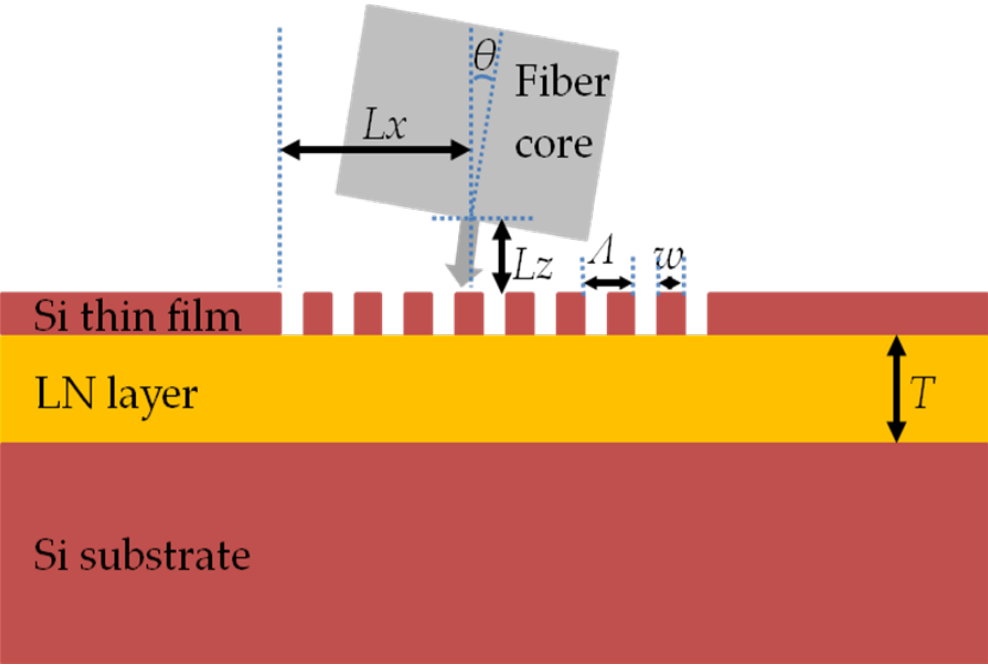
Figure 1. Schematic cross-section of a grating coupler in Si thin film on LN.